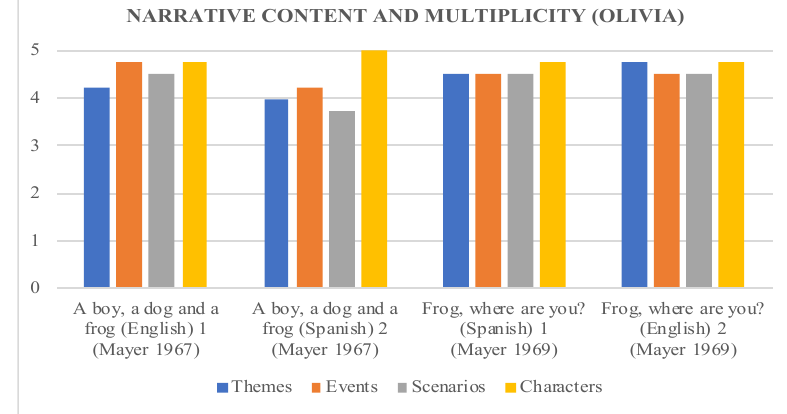
Figure 8 . Olivia’s scores for the narrative content and multiplicity dimension.